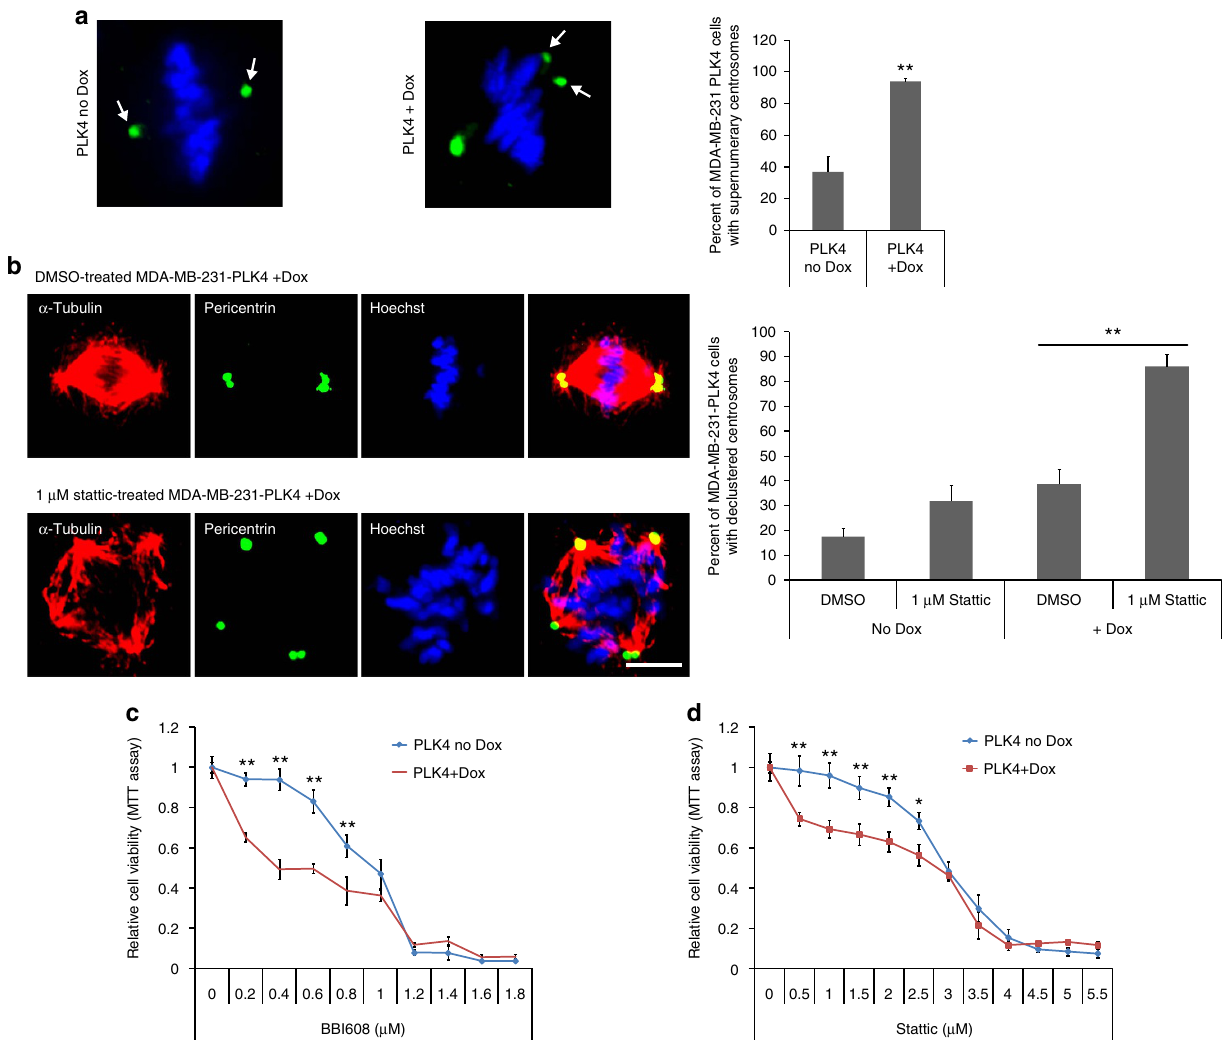
Figure 6 | Cells with centrosome amplification are more sensitive to Stat3 inhibitors. ( a ) Left: representative immunofluorescence images of MDA-MB-231 cells with doxycycline-induced, PLK4-dependent centrosome amplification. Pericentrin (green) and DNA (Hoechst, blue). Scale bar, 3 m m. Right: quantification of the number of doxycycline-induced (Dox) MDA-MB-231-PLK4 cells with supernumerary centrosomes. n ¼ 5 biological replicates, Z 100 cells per condition. ( b ) Left: representative immunofluorescence images of dimethylsulphoxide (DMSO)-treated and Stattic-treated MDA-MB-231 cells with doxycycline-induced, PLK4-dependent centrosome amplification. Tubulin (red), pericentrin (green) and DNA (Hoechst, blue). Scale bar, 3 m m. Right: quantification of the number of Stattic-treated doxycycline-induced (Dox) MDA-MB-231-PLK4 cells with declustered centrosomes. n ¼ 4 biological replicates, 160 cells per condition. ( c ) Quantification of cell viability (MTT assay) in BBI-608-treated MDA-MB-231-PLK4 cells with (PLK4 þ Dox) or without (PLK4 no-Dox) doxycycline-induced PLK4-608 expression. n ¼ 6 biological replicates. Statistical significance was tested between the no-Dox and Dox groups with analysis of variance (ANOVA). ( d ) Quantification of cell viability (MTT assay) in Stattic-treated MDA-MB-231-PLK4 cells with (PLK4 þ Dox) or without (PLK4 no-Dox) doxycycline-induced centrosome amplification. n ¼ 6 biological replicates. Statistical significance was tested between no-Dox and Dox groups with ANOVA. * P o 0.05; ** P o 0.01. Error bars represent